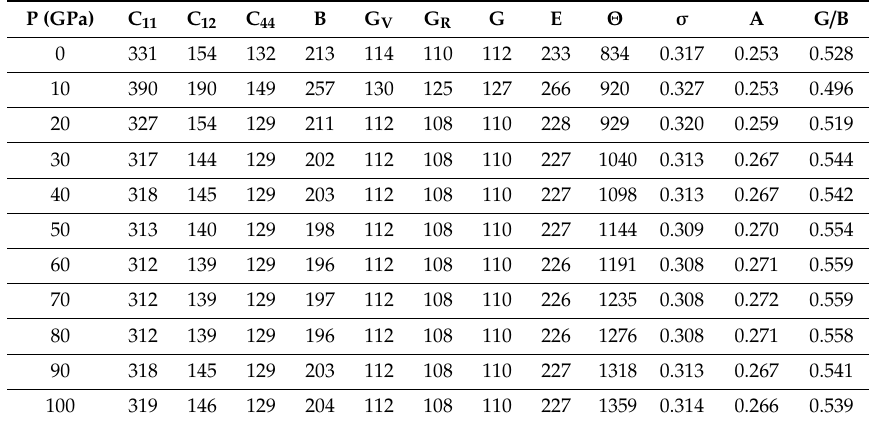
Table 4. The C ij (GPa), B (GPa), G (GPa), E (GPa), Θ , Poission ratio σ , anisotropy factor A and G / B of Co 2 Ti at various